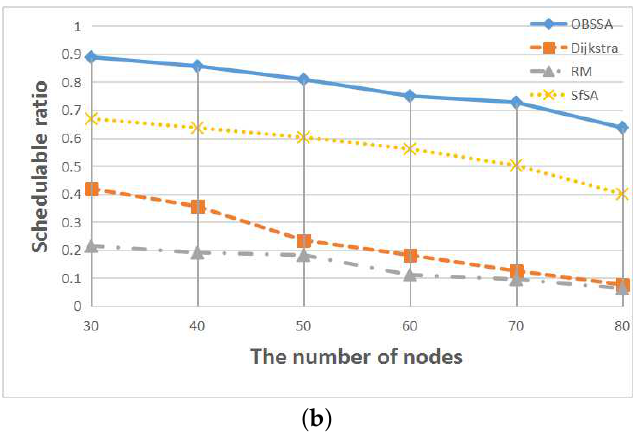
Figure 9. The relationship between the schedulability ratio and the number of nodes. ( a ) F = 15, U = 0.4; ( b ) F = 15, U =